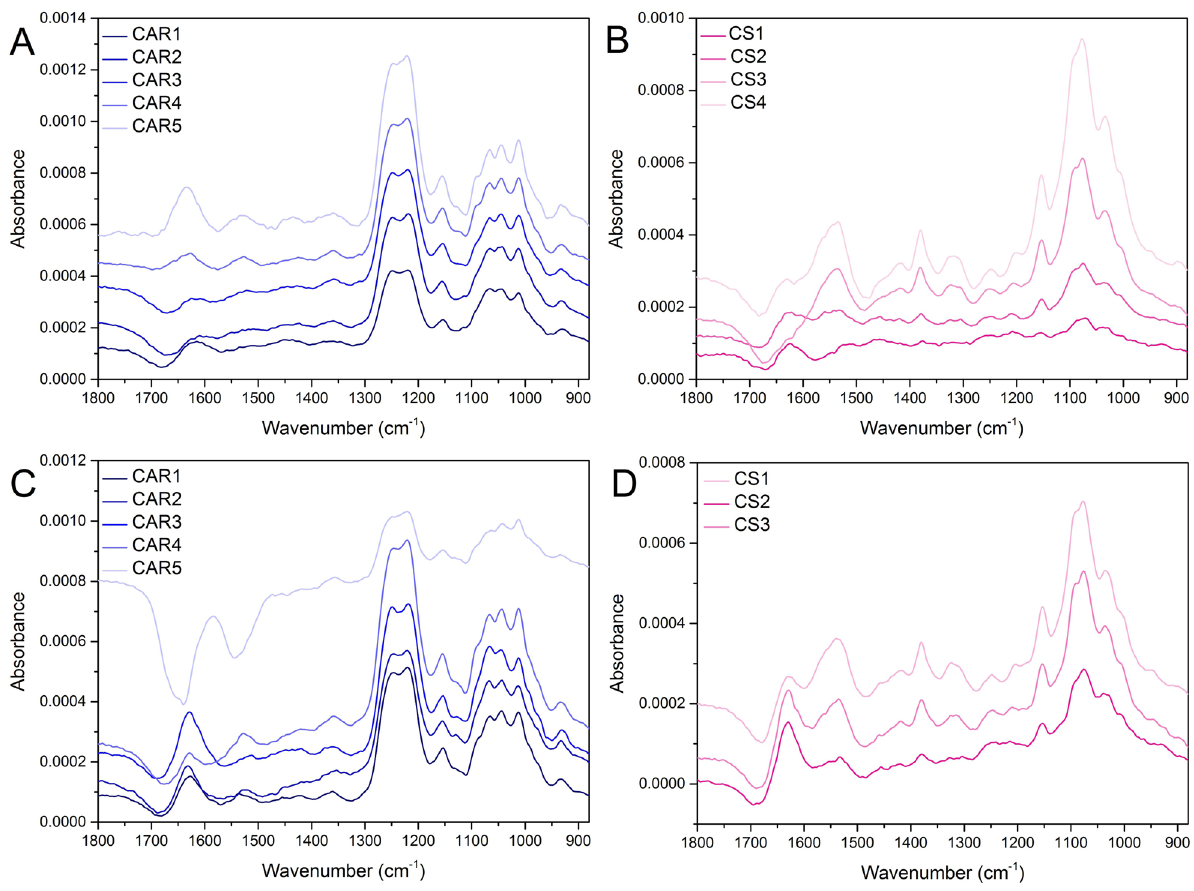
Figure 2. ATR FTIR spectra of discrete polymer layers 1 through 5 and 1 through 6 of the CAR (panel A ) and of the CS (panel B ) added to the CAR/CS multilayer without nisin Z and ATR FTIR spectra of discrete polymer layers 1 through 5 and 1 through 6 of the CAR (panel C ) and of the CS (panel D ) added to the CAR/CS multilayer that contained nisin Z. Spectra were processed by subtracting successive spectra from the previous spectra in the multilayer stack shown in Fig. 1.